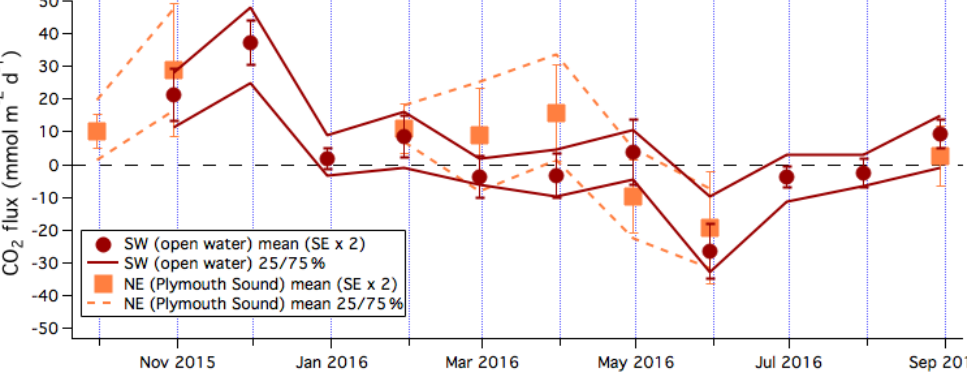
Figure 5. Monthly averages and 25th and 75th percentiles of CO 2 flux from the southwest (open water) and northeast (Plymouth Sound) wind sectors. Error bars indicate 2 times standard